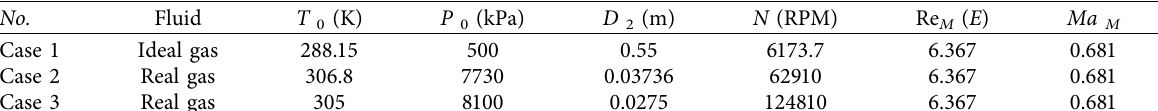
Figure 16: Comparison of numerically predicted results against the IET-CAS experimental data. (a) Compressor efficiency and (b) is- entropic work coefficient. Table 5: Settings of the SNL reference cases.